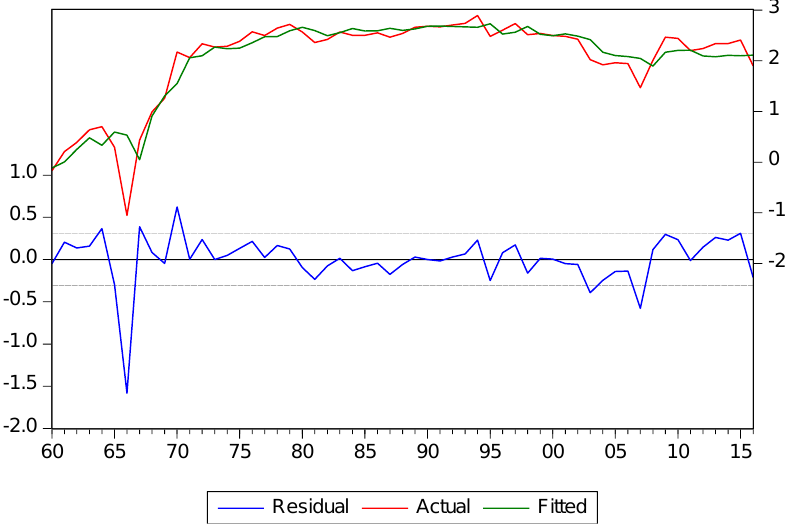
Figure 4. Logarithmic Environmental Kuznets Curve (EKC) and fitting curve of PCCEs and PCGDP in Singapore.